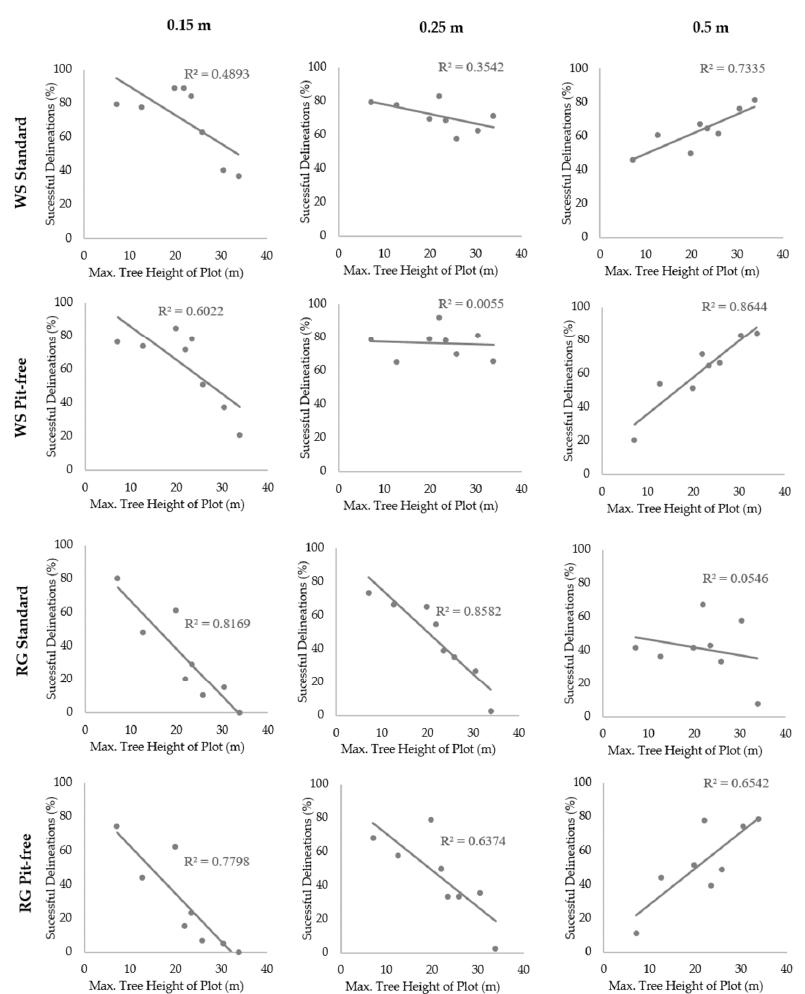
Figure 7. Scatterplots demonstrating the linear regression model fitted between successful tree crown delineations and maximum plot tree height in relation to CHM pixel size (0.15 m, 0.25 m and 0.5 m) and the four segmentation algorithm and CHM generation method combinations (marker-controlled watershed (WS) segmentation for standard CHM, marker-controlled watershed segmentation for pit- free CHM, region growing (RG) segmentation for standard CHM and region growing segmentation for pit-free for pit-free CHM).